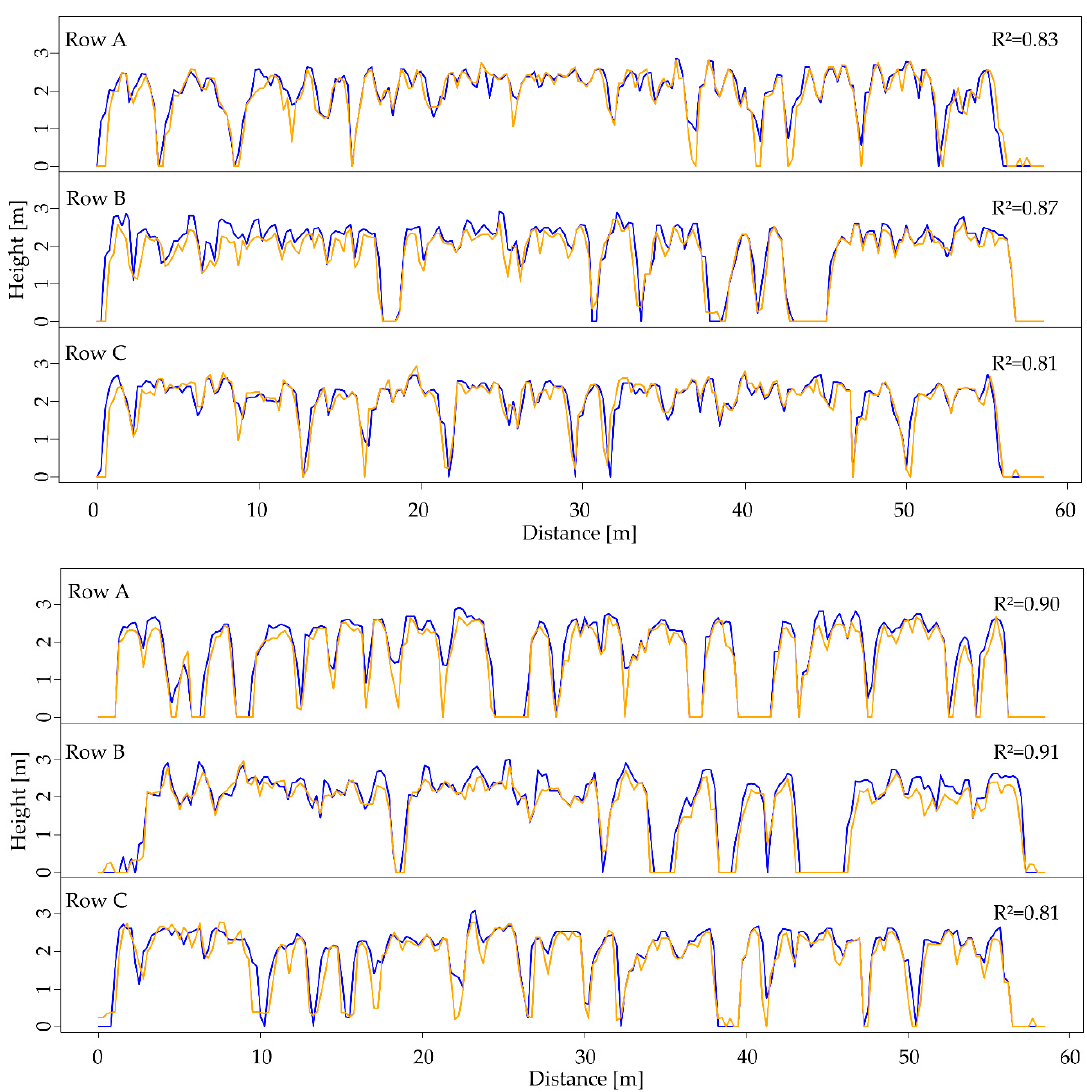
Figure 3. Maximum tree wall height estimations from UAV ( orange ) and light detection and ranging (LiDAR) ( blue ) point clouds for each 0.25 m in apple tree rows A, B, and C for 2018 ( top ) and 2019 (bottom).